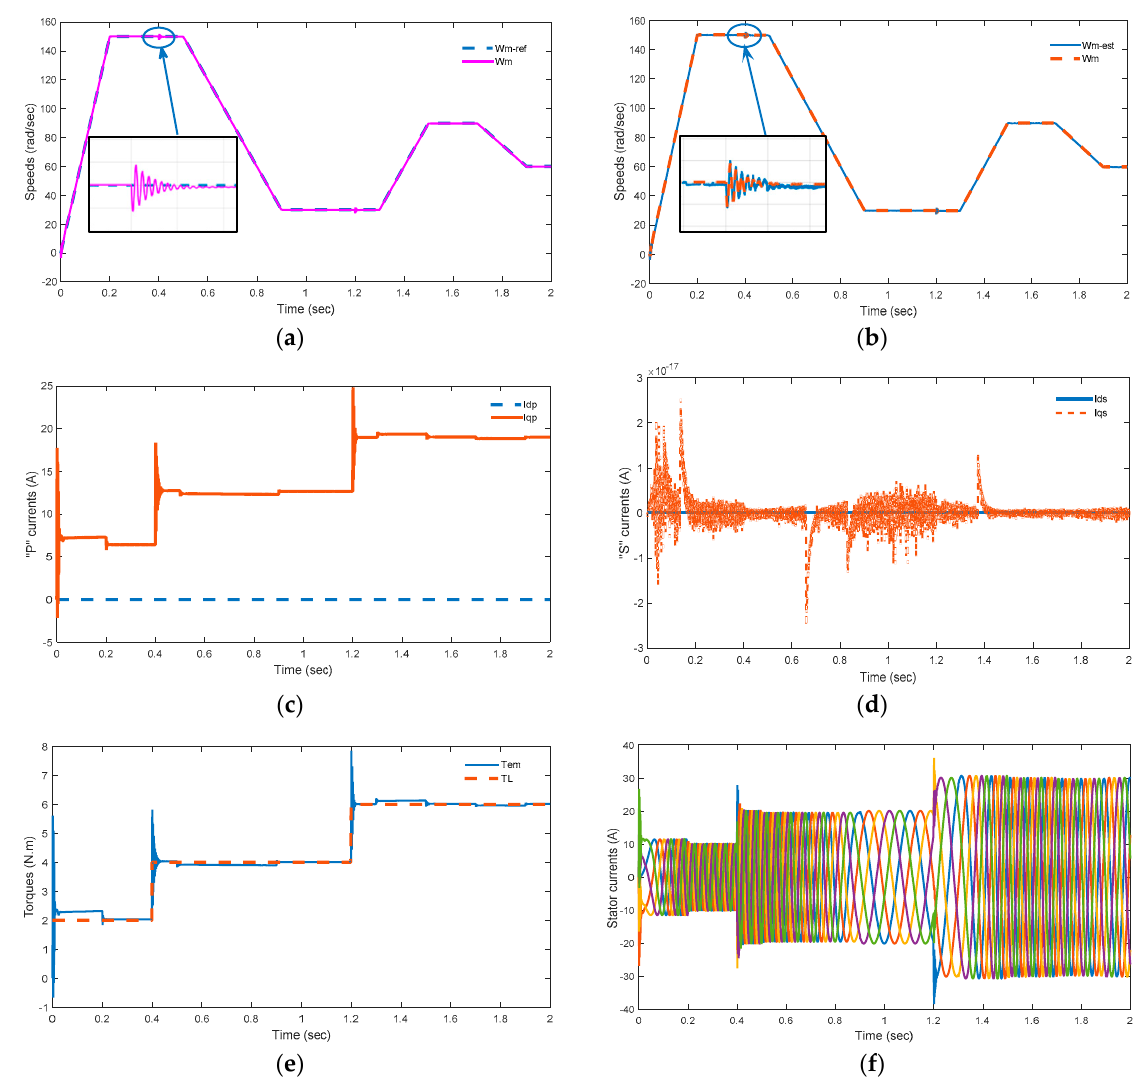
Figure 4. 5P-PMSM performance in normal operation condition. ( a ) Speed dynamics with load torque aplication; ( b ) measured and estimated speeds; ( c ) measured ( d p , q p ) current responses; ( d ) measured ( d s , q s ) current responses; ( e ) electromagnetic and load torque responses; ( f ) stator phases currents.